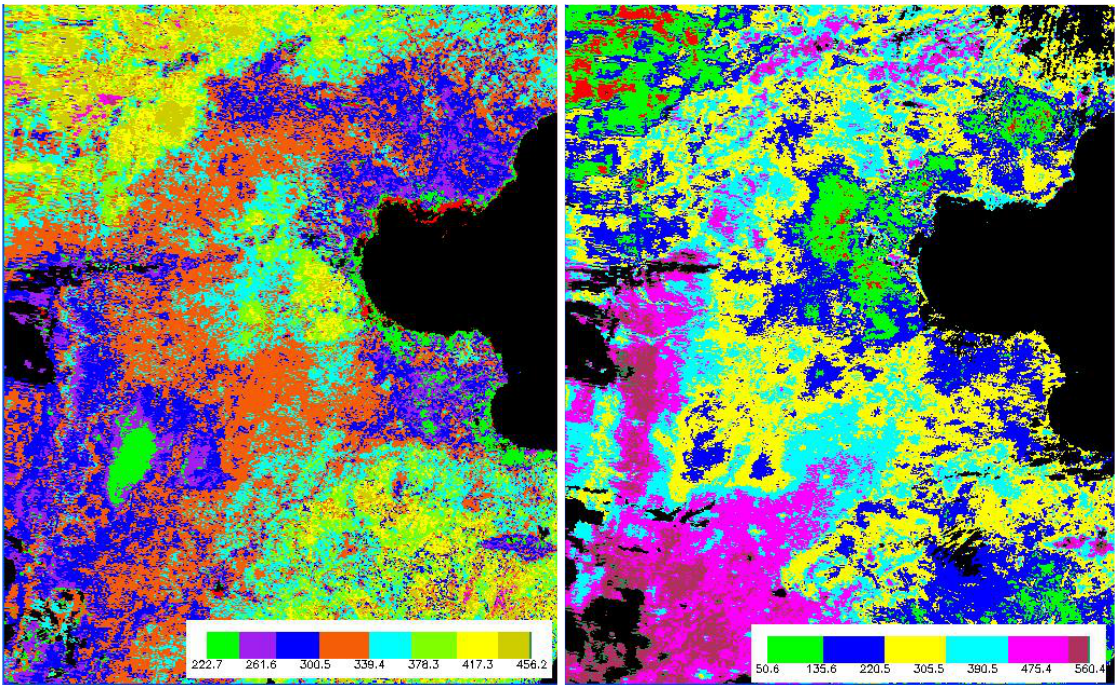
maps on May 2, 2005 in North China Plain retrieved by the improved Figure 8. λ E veg model (left image) and the original model (right